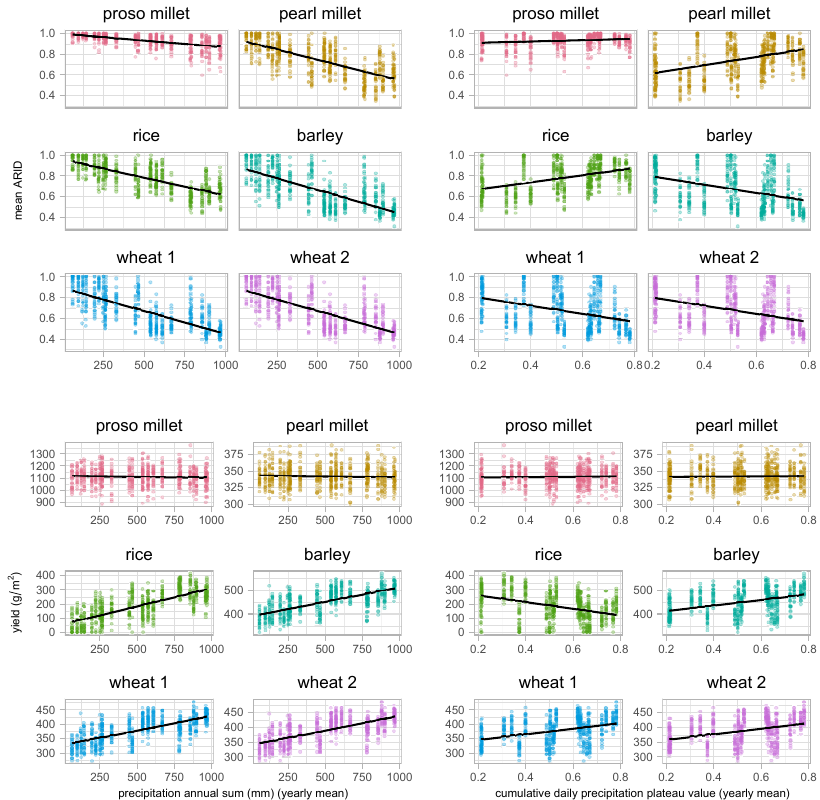
Figure 5. Mean growing season ARID and yield per crop versus the variation of two precipitation parameters: annual sum (yearly mean), and the plateau value of the cumulative curve of daily precipitation (i.e., the balance between winter and summer